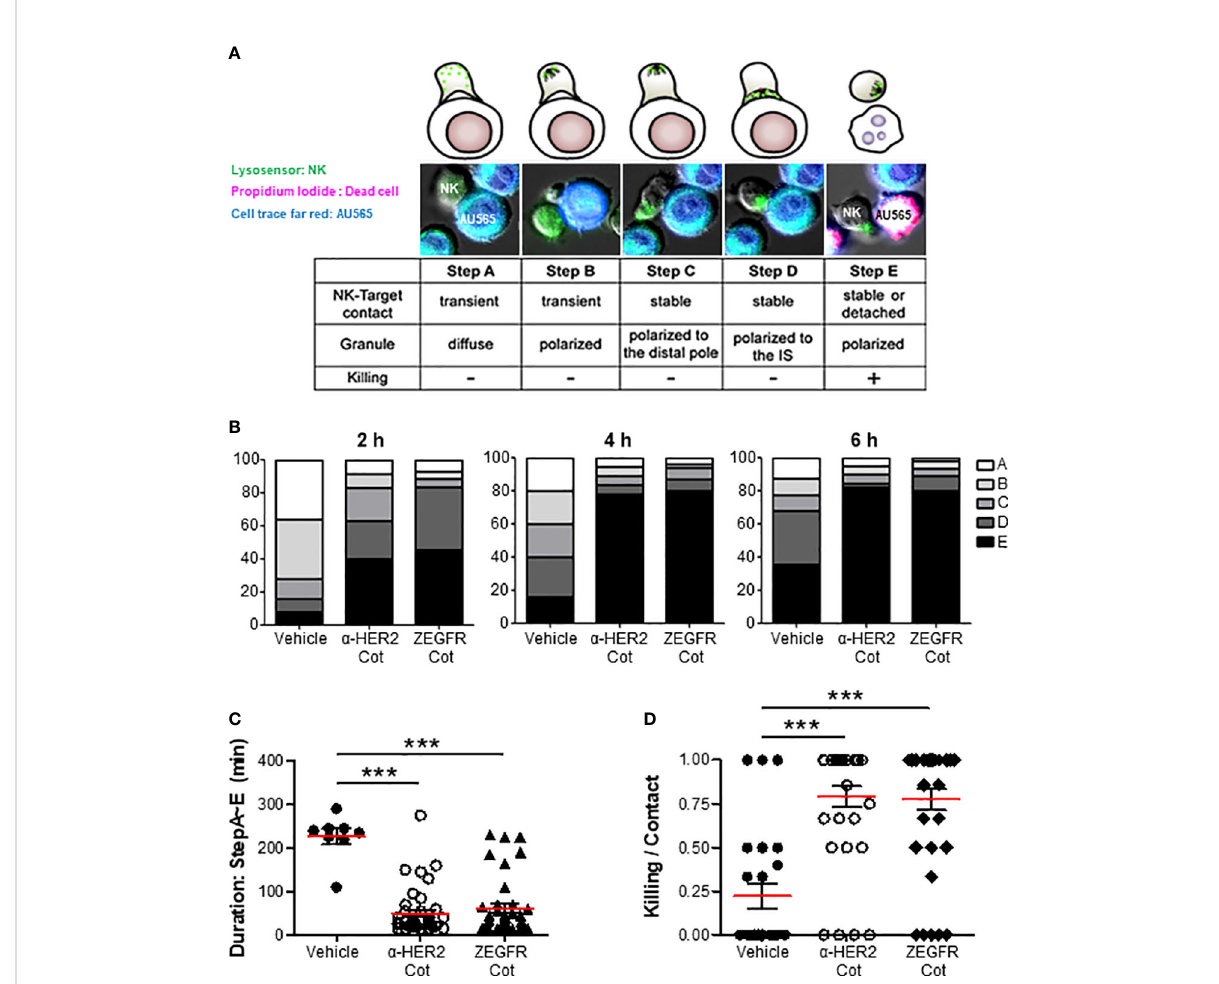
FIGURE 4 a -Cot-NK92 cells acts in a conjugator-dependent manner at the immune synapse (A) Images depicting the sequential steps in the interaction between a -Cot-NK92 and AU565 cells with or without conjugators ( a -HER2-Cot and ZEGFR-Cot). The a -Cot-NK92 and AU565 (HER2 + EGFR + ) cells were labeled with LysoSensor Green and DDAO-SE, respectively, and co-cultured in a medium containing propidium iodide to assess the lytic dynamics of a -Cot-NK92 cells with or without conjugators. Images were acquired using a fl uorescence microscope. The snapshots are provided in Supplementary Mov1. (B) Percentage of a -Cot-NK92 cells remaining at each step after 2, 4, or 6 h of co-incubation with AU565 cells with/without conjugators. (C) Duration of the process, and (D) ratio of a -Cot-NK92 cells that kill target cells for target-contacting cells. Data are shown as the mean (red line) ± S.D. Statistical signi fi cance of differences between groups was evaluated using paired Student ’ s t- test. *** P < 0.001. Cot, cotinine; NK, natural